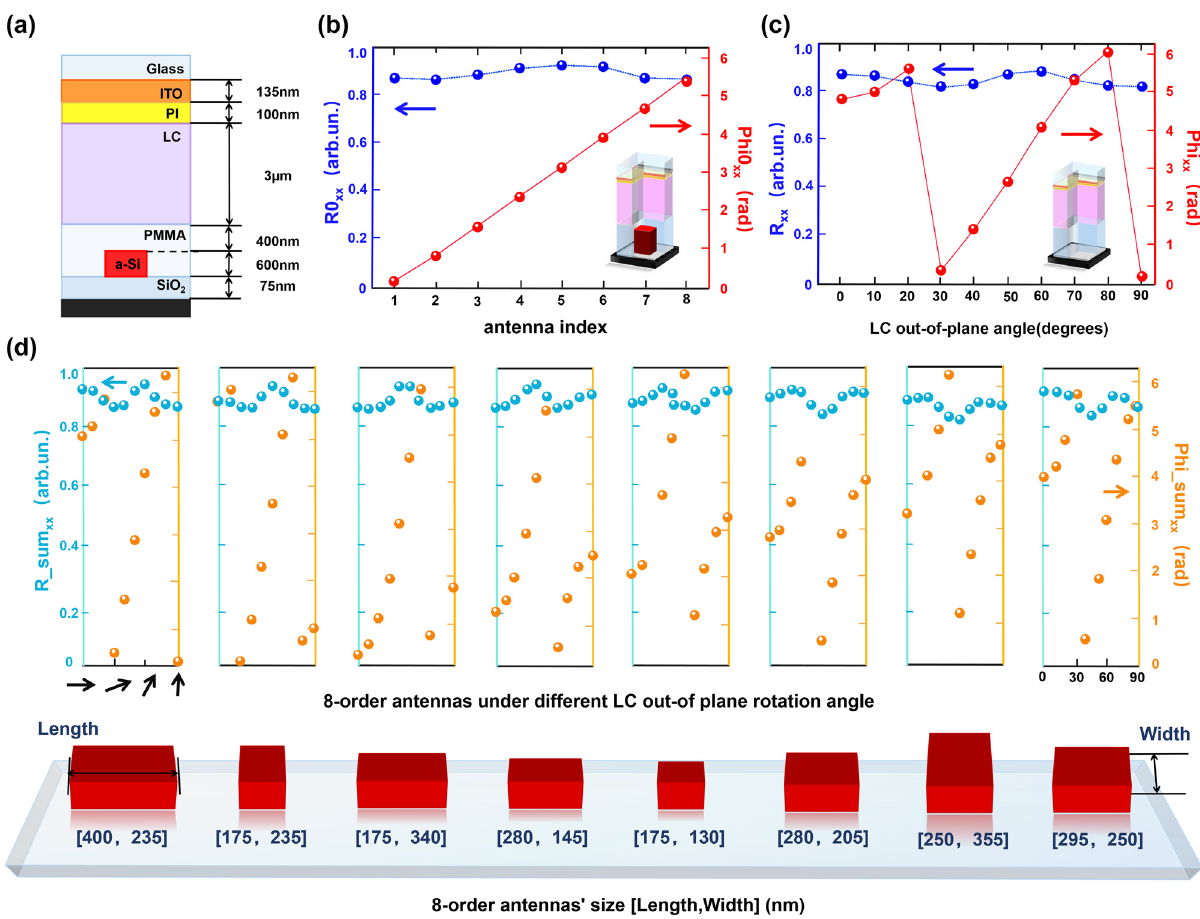
Figure 2: Simulation results of the dielectric antenna. (a) The schematic diagram of the unit cell. (b) The reflection coefficient (amplitude R 0 phase Phi 0 ) of the first pixel model with only selected 8-order antennas. Both the LC’s in-plane and out-of-plane angle are fixed at 0 ◦ under xx and phase Phi ) of the second pixel model with the antenna removed and only the x -polarized illumination. (c) The reflection coefficient (amplitude R xx xx LC out-of-plane angle changes from 0 ◦ to 90 ◦ under x -polarized illumination. (d) After reassembling the two pixel models, each 8-order selected antenna maintains a high reflectivity and covers the range from 0 to 2 π when the LC out-of-plane angle changes from 0 to 90 ◦